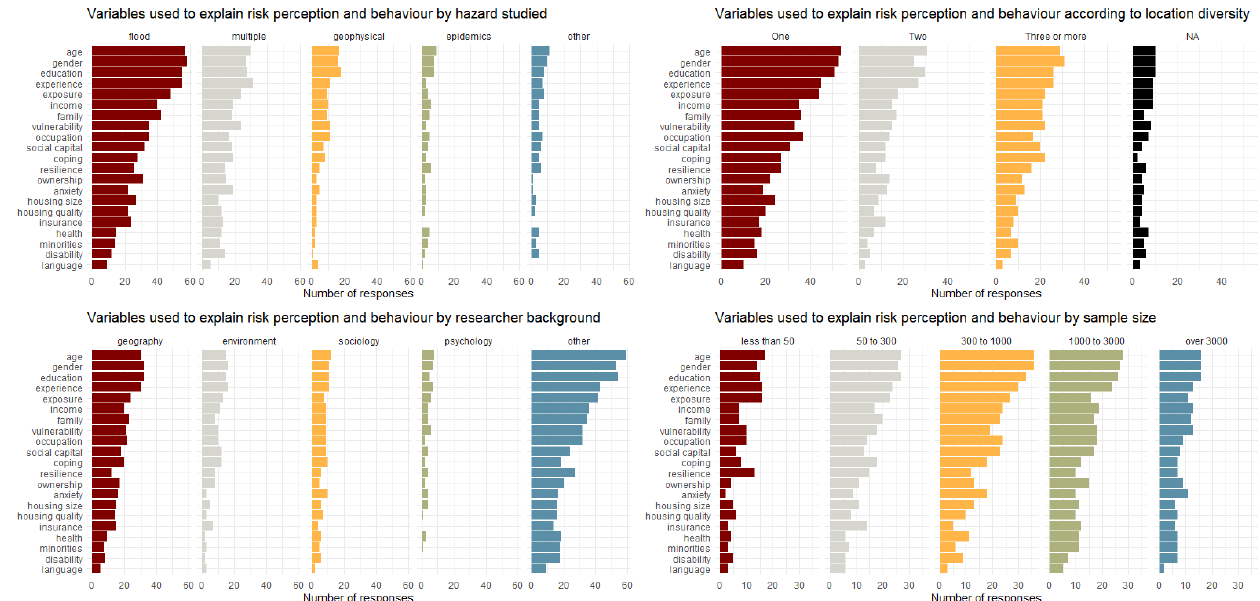
Figure 11. Explanatory-variable selection according to the background of respondents and study characteristics. NA stands for “no answer”.